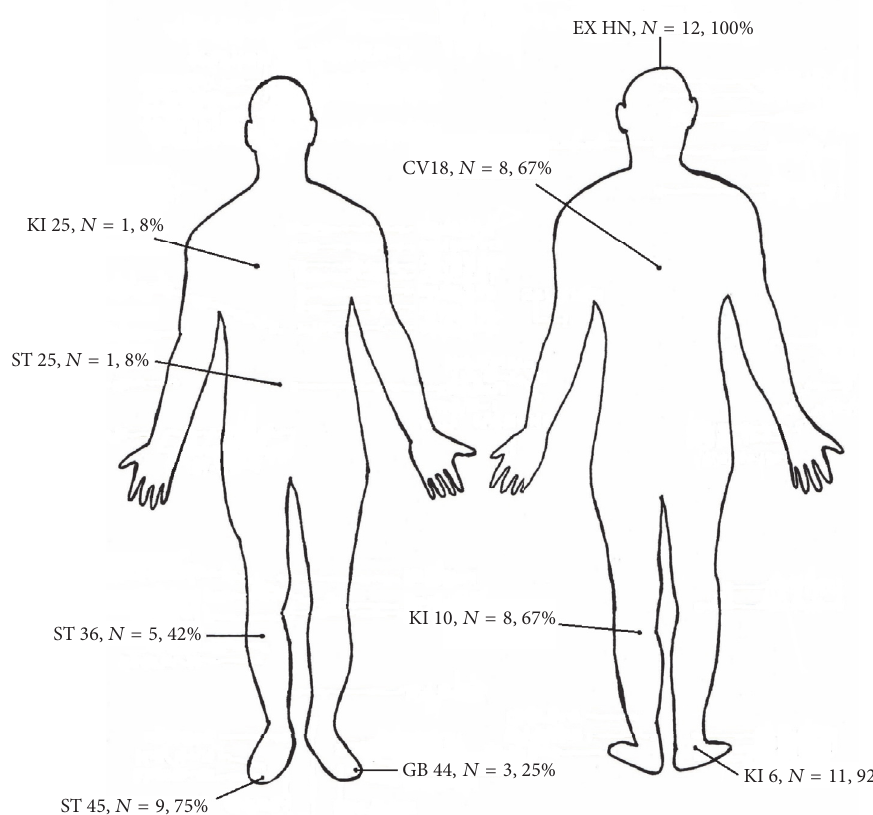
Figure 1: An overview of the acupuncture points (including the absolute frequency numbers and percentage scores) that were used during the 12 weekly acupuncture treatments of our 44-year-old female outpatient suffering from chronic schizophrenia and sleep disorders.